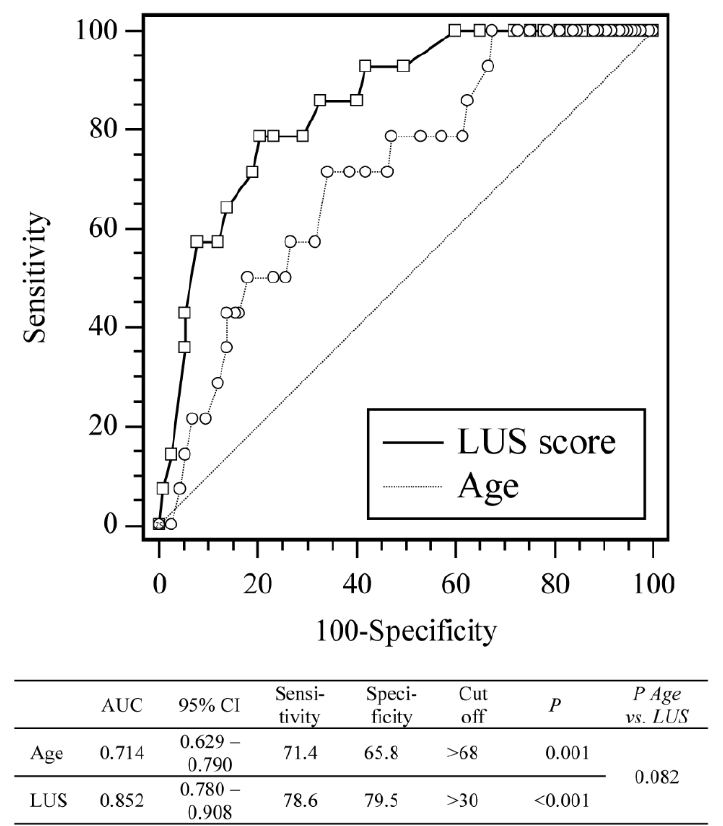
Figure 2. Receiver operating curve analysis of sensitivity, specificity, and cut-off values for LUS score and age according to highest respiratory modality (mechanical ventilation).